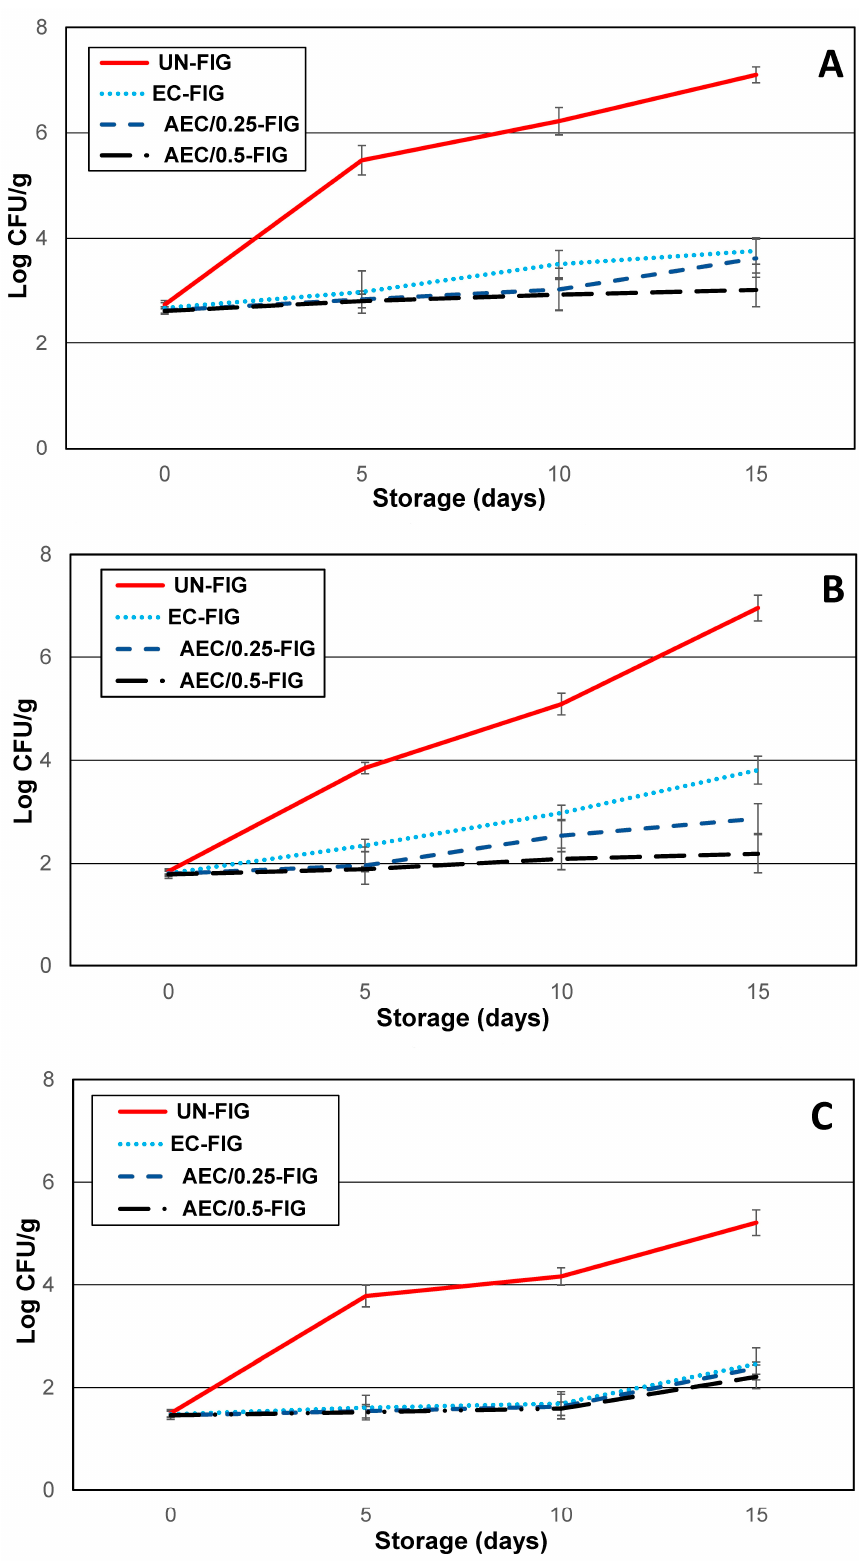
Figure 2. Representation of growth kinetic of spoiling bacteria, yeast, and mold populations and Enterobacteriaceae during storage at 4 °C for 15 days for all different preservation methods. Error bars indicate standard deviation (±SD). ( A ) TMC (total mesophilic microflora); ( B ) yeast/mold; ( C ) Enterobacteriaceae .